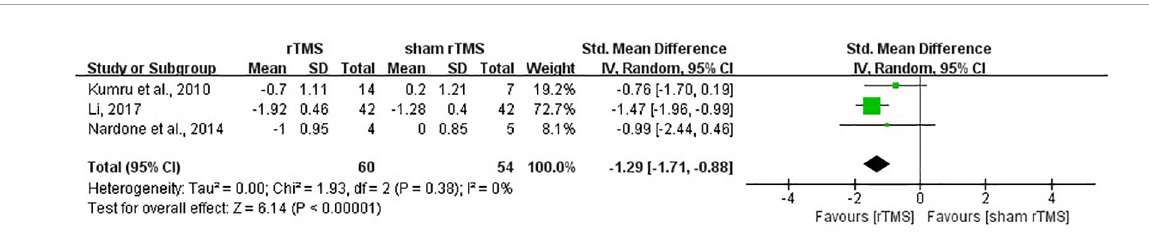
FIGURE7 The forest plot of MAS in comparison of rTMS versus sham